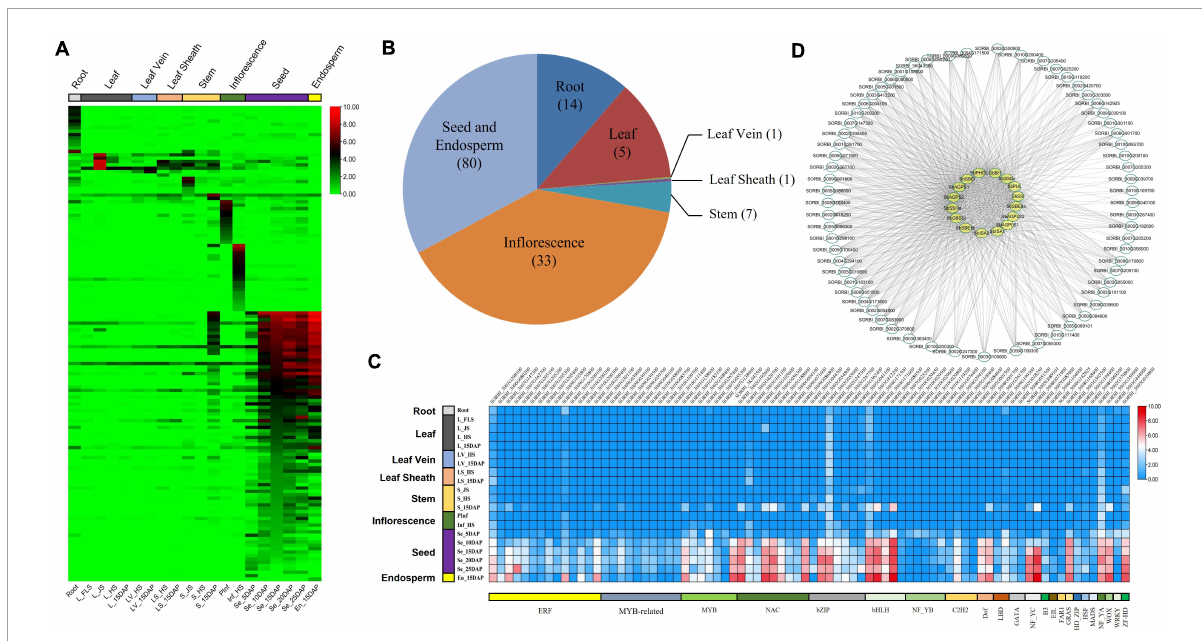
FIGURE4 Tissue-specific detection of TFs in sorghum via RNA-seq. (A) Heat map showing the tissue-specific expression of TFs in sorghum. (B) Category of highly expressed TFs in sorghum. (C) Distribution of tissue-specific genes detected in all tissues and samples. Results of each tissue were summarized across multiple samples with corresponding development stages. (D) Co-expression analysis of TFs and sorghum starch biosynthesis-related